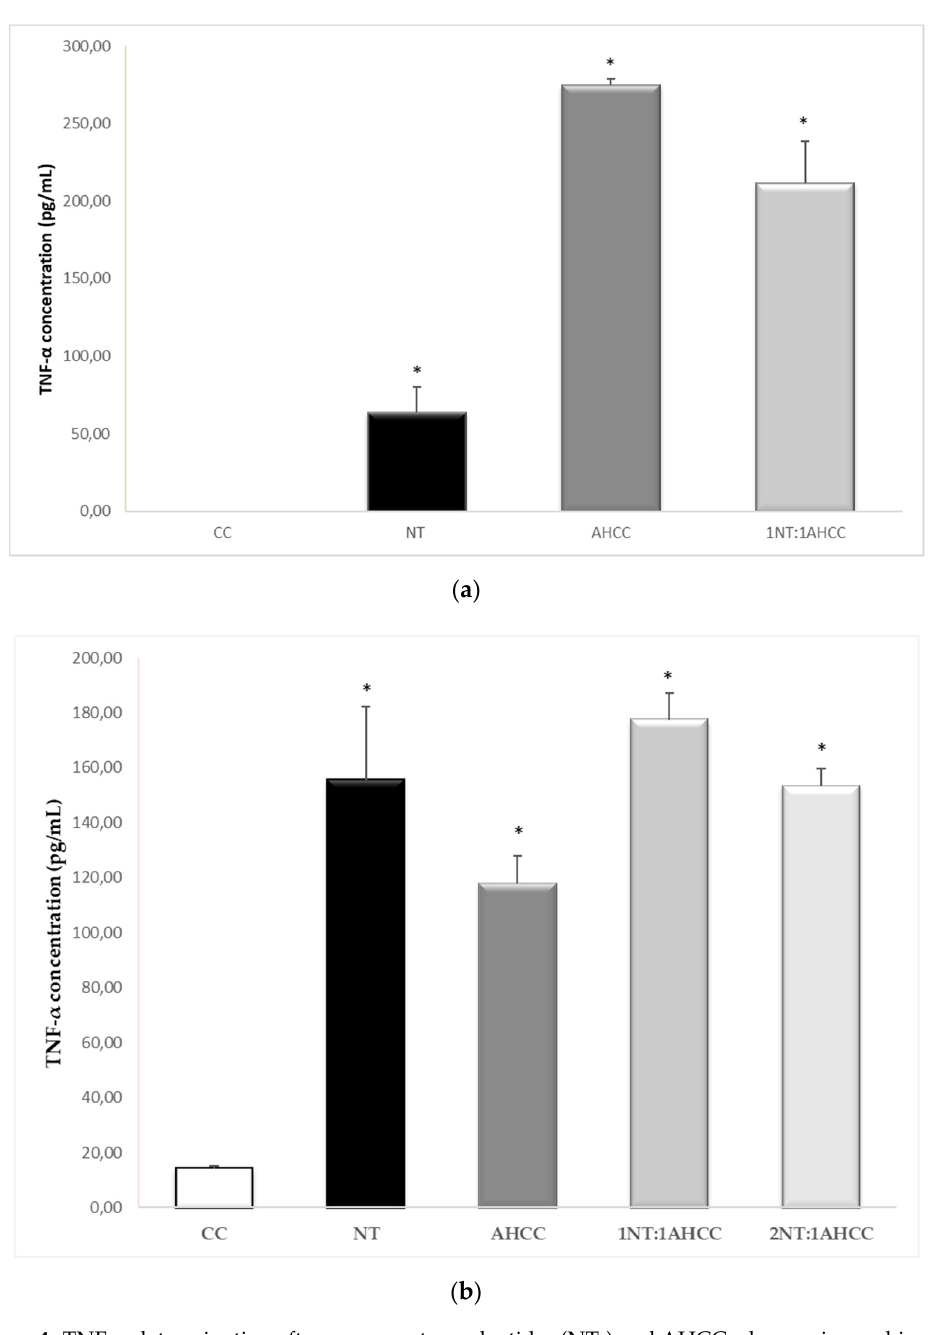
Figure 4. TNF- α determination after exposure to nucleotides (NTs) and AHCC, alone or in combination in L . infantum -infected macrophages ( a ) and L. infantum -infected macrophage / lymphocyte cocultures ( b ). * p < 0.05 versus the